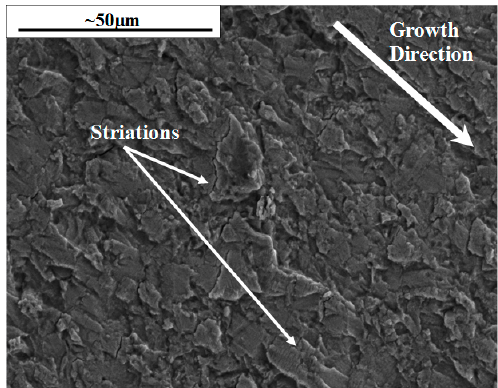
Figure 14. Transgranular dominant failure for 180° OOP tests showing the fracture surface at ∆ K = 20 MPa √ m.